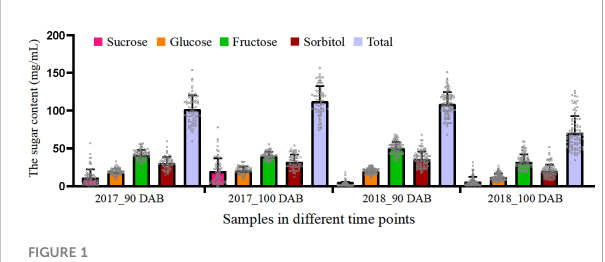
FIGURE 1 Average content of four types of sugars in “ Zaoshengxinshui ” and “ Qiushui ” and their 92